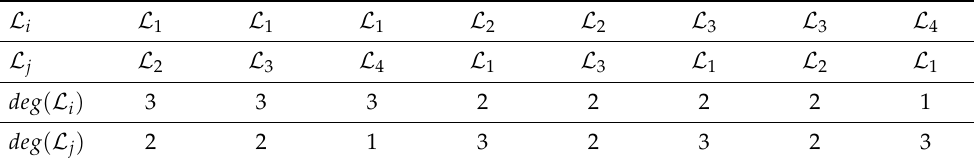
Table 1. Degree of each pair of adjacent nodes in the